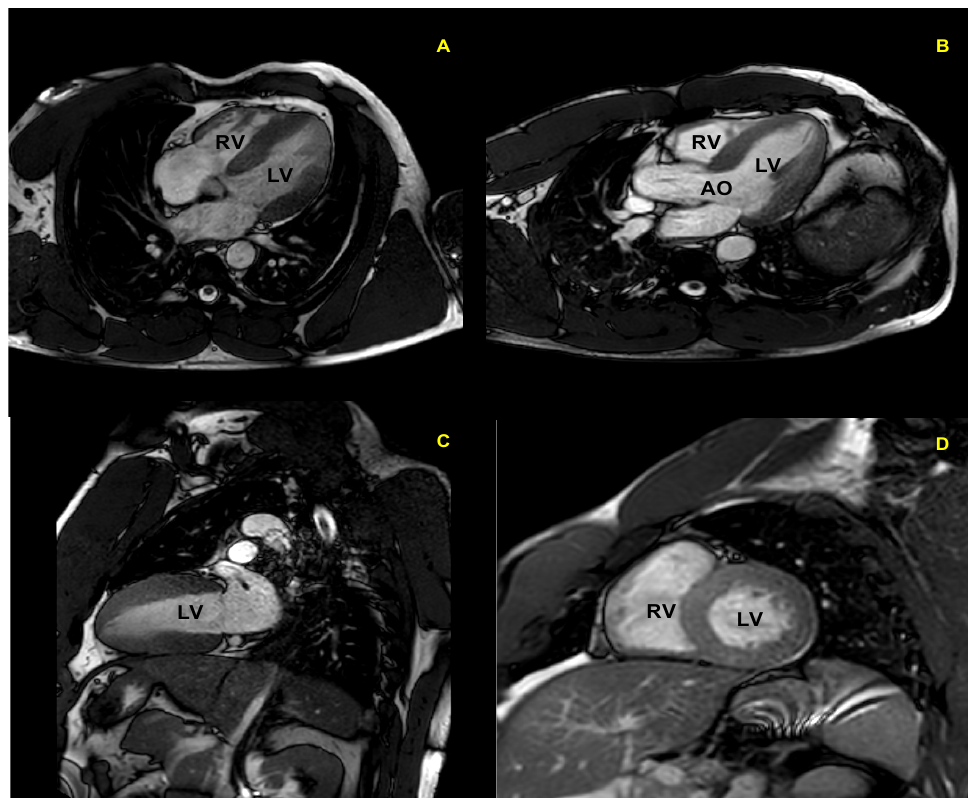
Figure 4. Cardiac magnetic resonance in an endurance athlete (long-distance swimmer). A symmet- ric dilatation of both right and left ventricular chambers is clearly depicted in 4-chamber (left panel) and 5-chamber (right panel) views. AO: aorta; LV: left ventricle; RV: right ventricle.